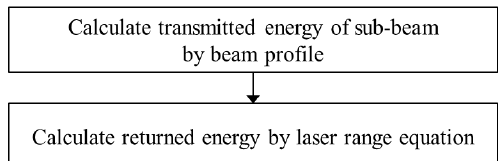
Figure 7. Processes of radiometric simulation